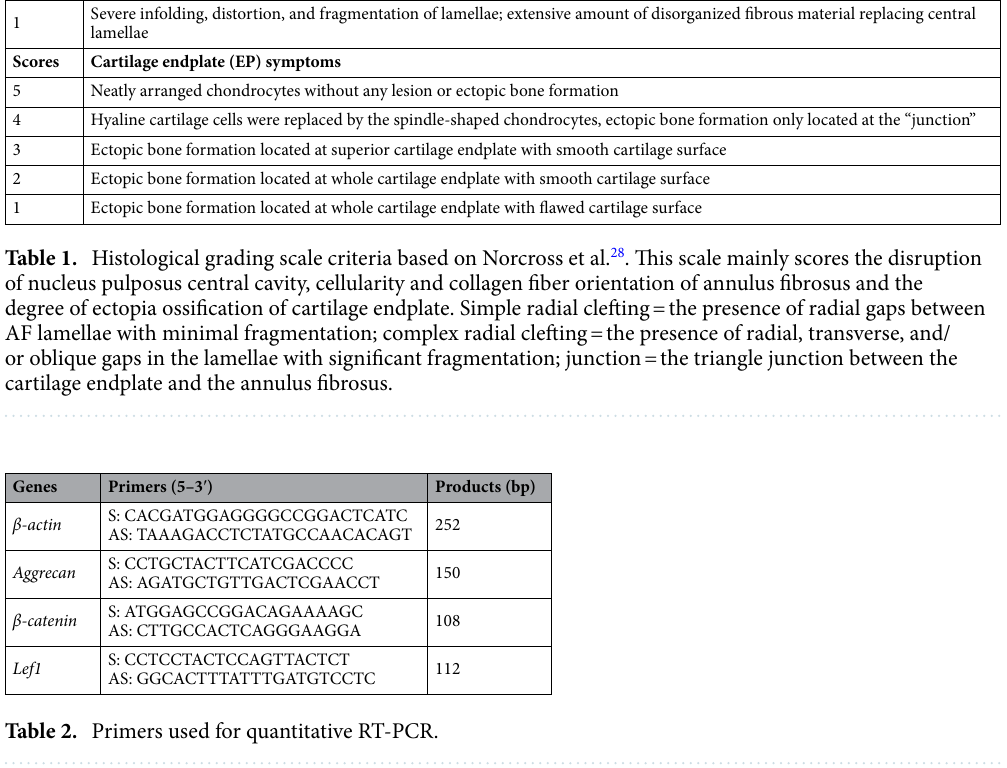
Table 2 and the gel electrophoresis was done to make sure the primers were available. The data were analyzed using the 2 -ΔΔCT method 64 . Statistics analysis. All the data were expressed as mean ± standard error of mean (sem), as indicated in the figure legends. Statistical significance was determined using Student’s t -test. All data analysis was performed using SPSS 15.0 analysis software (SPSS Inc, Chicago, Illinois, USA) and the level of significance was defined as P < 0.05.